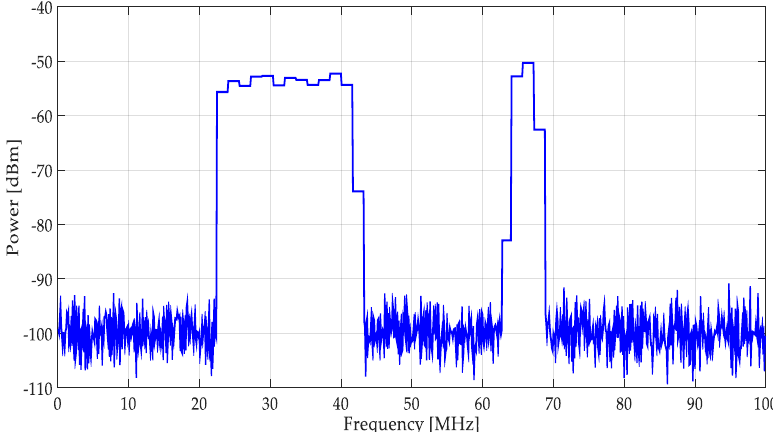
Figure 7. The resulting spectrum used in the decision rule to detect primary users (PUs).